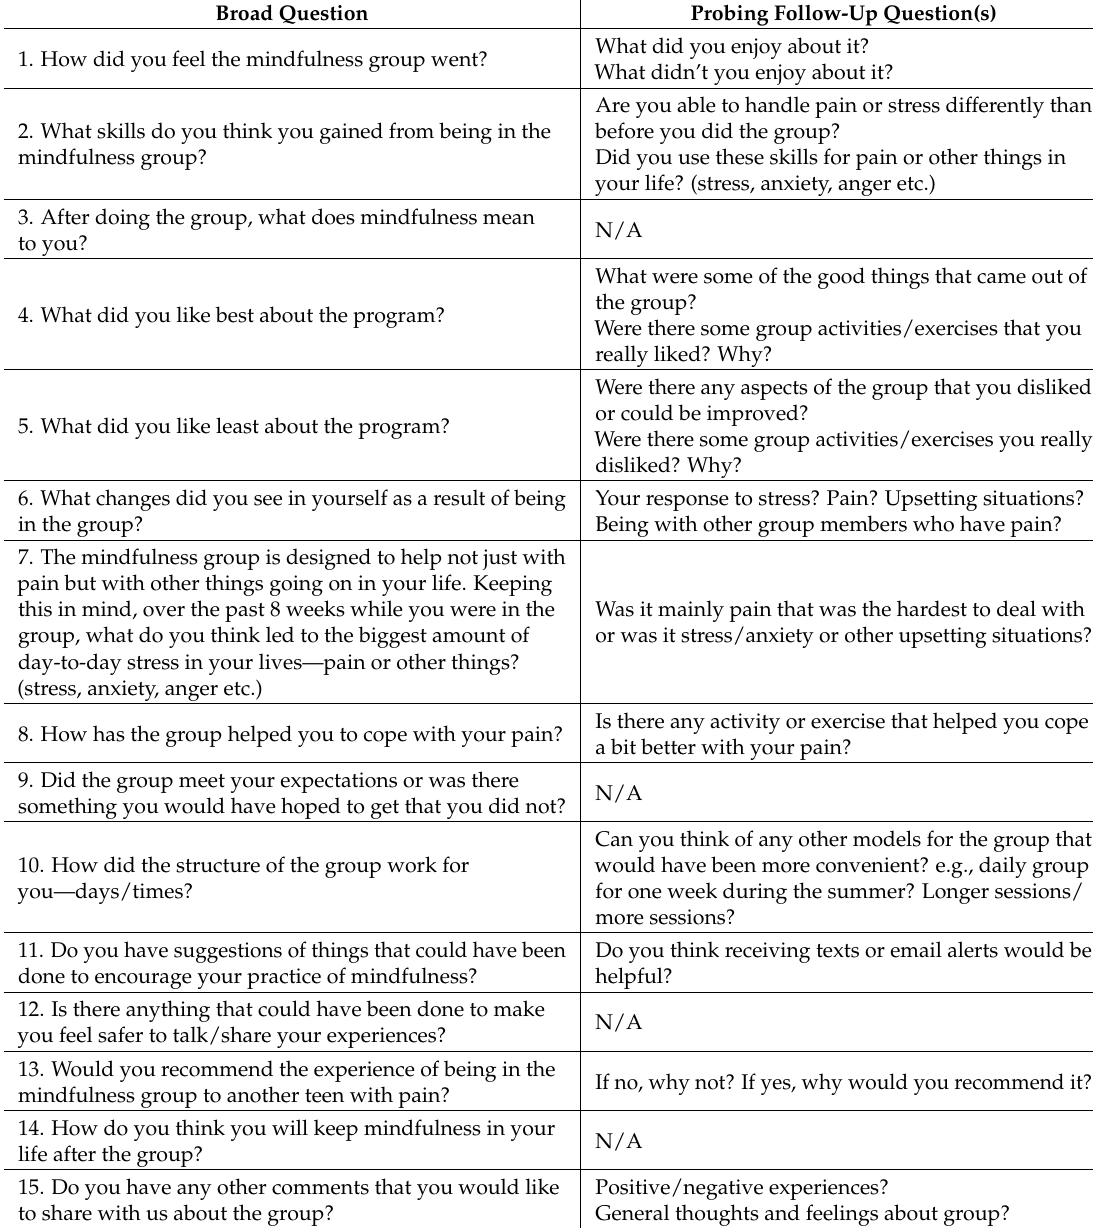
Table A1. Focus group semi-structured interview